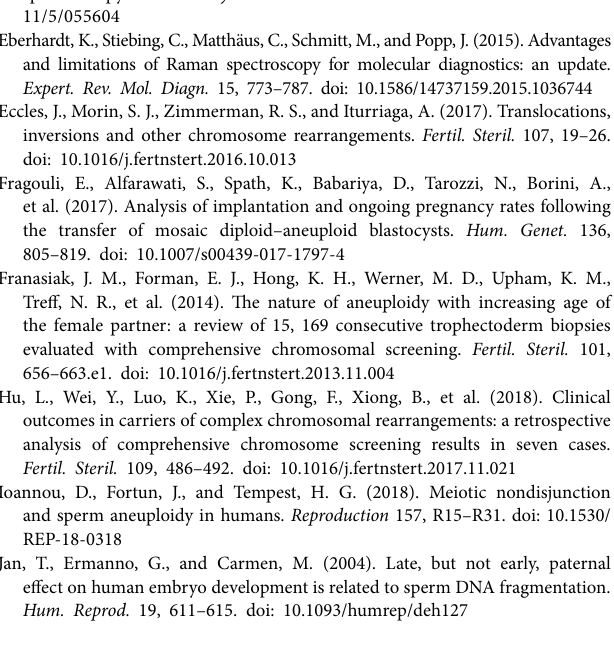
Supplementary Figure S1 | Optimization of spectral acquisition method. (A) Laser exposure time 0.5 s scanning once (red) and 0.2 s scanning three times spectrogram (black). (B) Laser exposure time 0.5 s scanning once and 15 times spectrogram. (C) Scanning map of a point in the sperm nucleus and its corresponding scanning position (scale bar, 100 μ m). (D) The spectrogram of multiple sperm scans and corresponding Raman scans (scale bar, 100 μ m). Supplementary Figure S2 | Original and processed spectra. Comparison between original spectrum and spectrum after automatic correction and smoothing by software (purple line: origin, green line: correction; red line: correction and smoothing). Supplementary Figure S3 | Frequency statistics of sperm spectra. (A–D) Frequency distribution histogram of 20 Y sperm and 39 X sperm data at I785 and Area (714–1,162); red dotted line: the potential critical value of the frequency distribution near the mean and